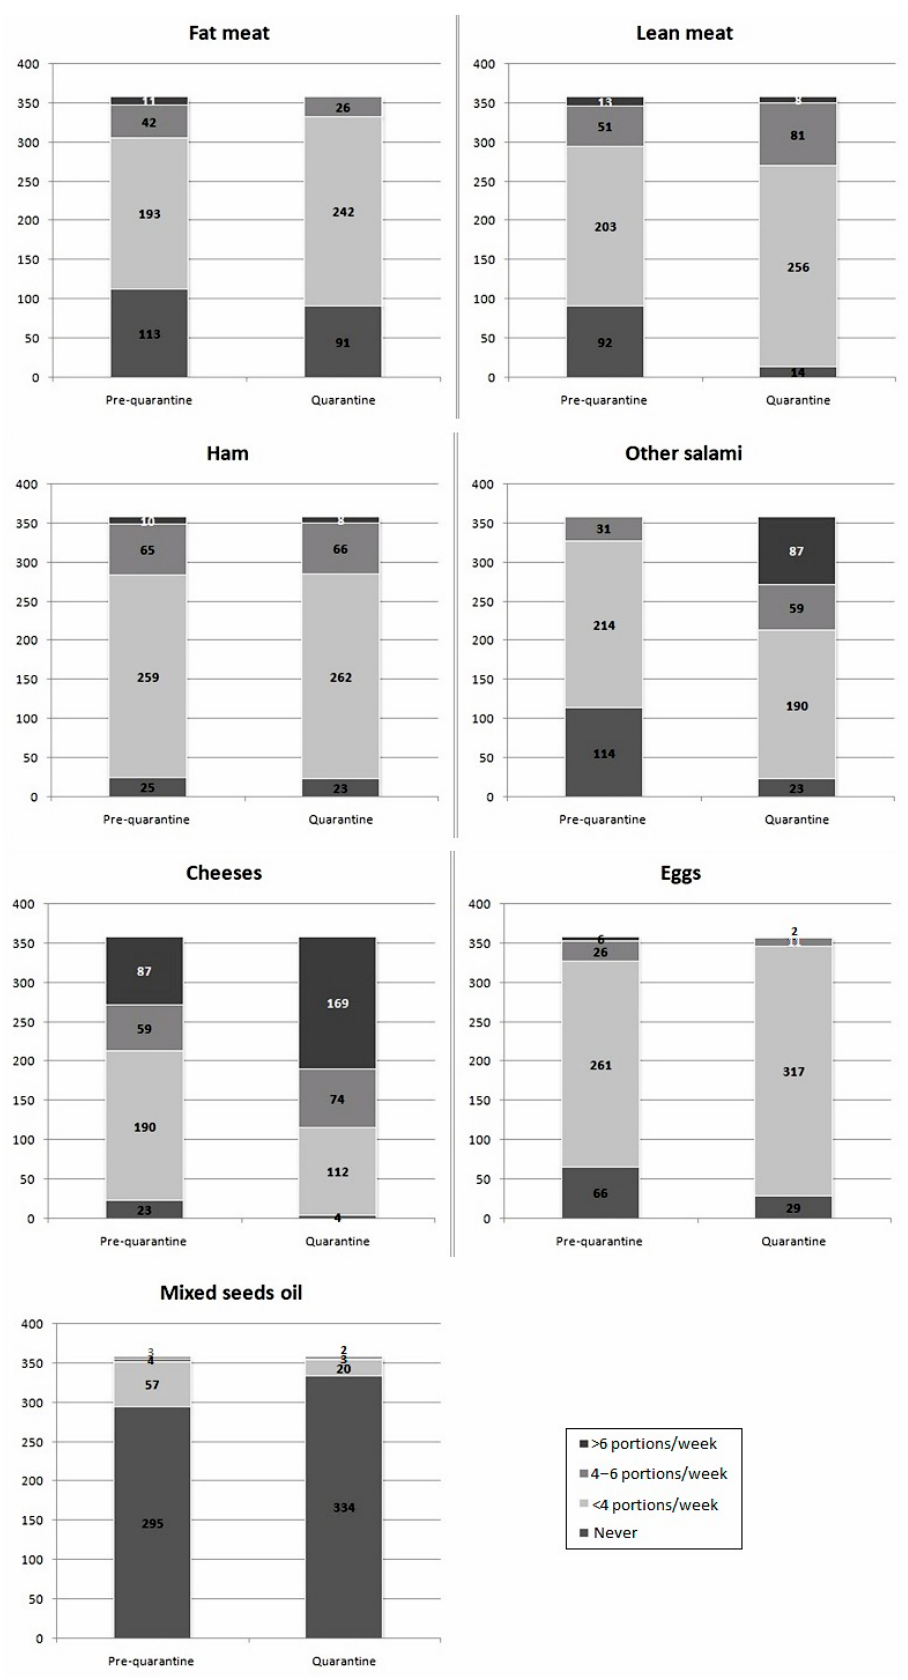
Figure 3. Changes in single food groups intake during quarantine